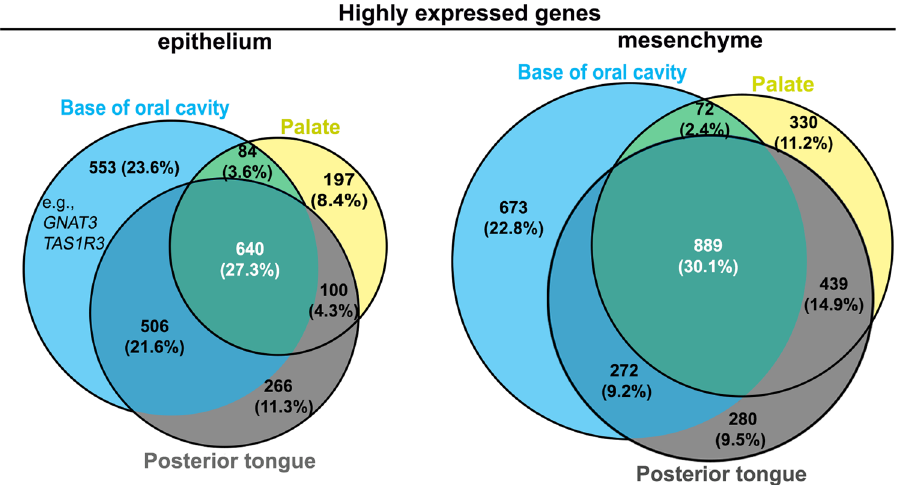
Figure 1. Number and overlapping of DEGs between epithelium and underlying mesenchyme of the palate, base of oral cavity, and posterior tongue in P3 male chickens. The highly expressed genes in the oral epithelium (left) or the underlying mesenchyme (right) in different tissues were analyzed separately followed by further comparisons of highly DEGs in the epithelium (left) or mesenchyme (right) of different tissues. The DEGs were determined by statistical algorithms Cuffdiff and DESeq2. Notably, the base of oral cavity had a greater number of highly expressed DEGs ( p < 0.05) in both the epithelium and mesenchyme compared to the palate and posterior tongue. Genes that are well known to be involved in taste perception, e.g., GNAT3 , TAS1R3 , were revealed as highly DEGs in the epithelium of the base of oral